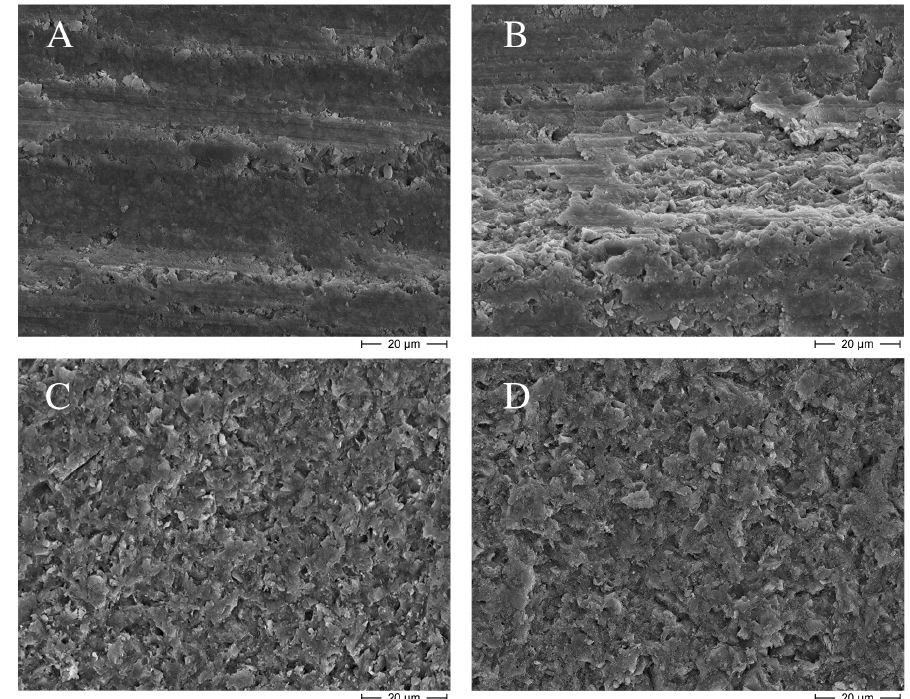
Figure 1. Scanning electron micrographs of the different surface treatments: ( A ) Negative reference, red code diamond bur; ( B ) Group 3, blue code diamond bur; ( C ) Group 4, sandblasting with Al 2 O 3 particles; and ( D ) Group 6, sandblasting with CoJet Sand. Etching with phosphoric acid (Group 2) did not affect the microscopic appearance of the surfaces, which looked similar to those of the negative reference ( A ) and were therefore not presented here.